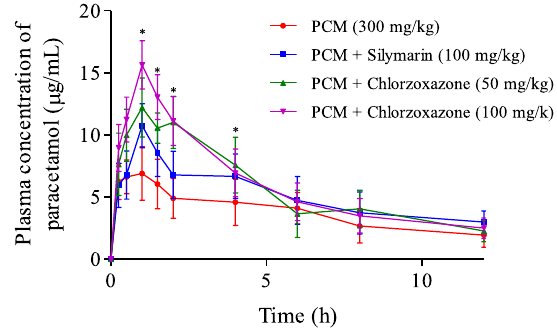
p < 0.05, *** p < 0.01 when compared to paracetamol alone group